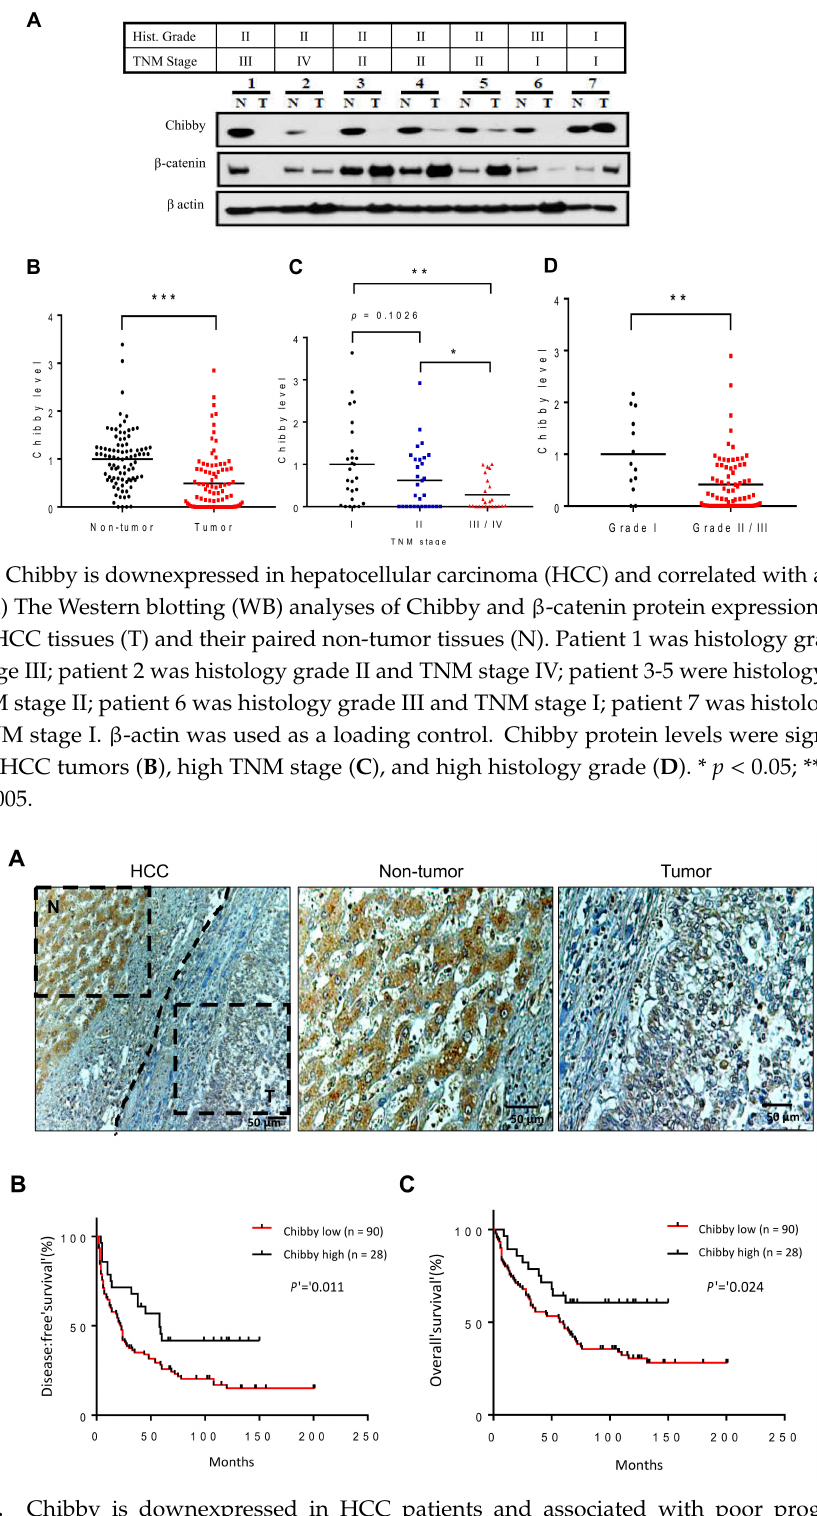
Figure 2. Chibby is downexpressed in HCC patients and associated with poor prognosis by immunohistochemistry (IHC) analysis. ( A ) IHC of Chibby in HCC tissue specimens (T) and respective non-tumor tissue specimens (N). Samples were classified into two groups according to Chibby expression: Chibby high group (28 of the 118 (23.7%)) and Chibby low (90 of the 118 (76.3%)). Kaplan–Meier disease-free survival ( B ) and overall survival curves ( C ) of “Chibby high” and “Chibby low” group HCC patients. Scale bars: 50 µ